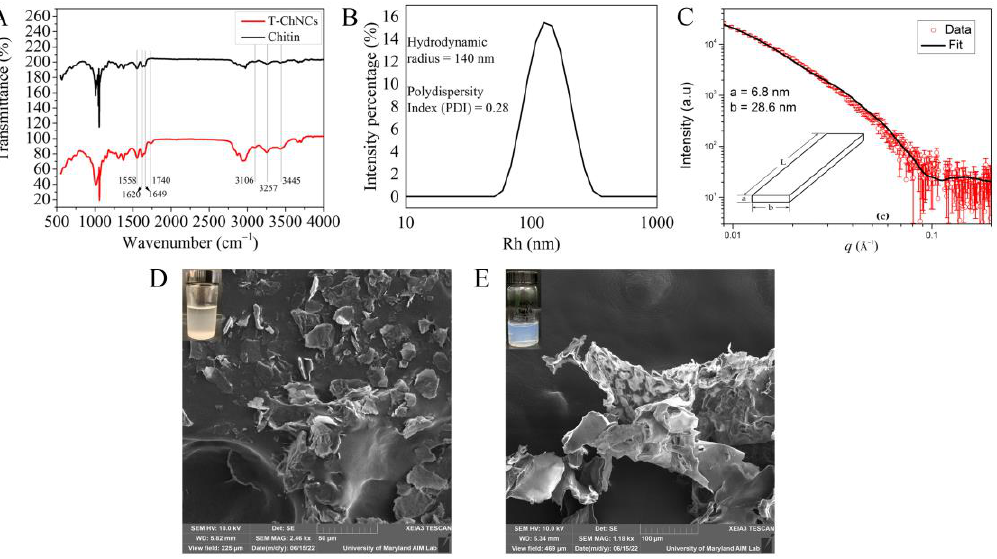
Figure 2. ( A ) FTIR spectra of chitin and TEMPO-oxidized chitin nanocrystals (T-ChNCs). ( B ) DLS analysis of T-ChNCs. ( C ) SAXS analysis of T-ChNCs. ( D ) SEM of chitin and ( E ) T-ChNCs.